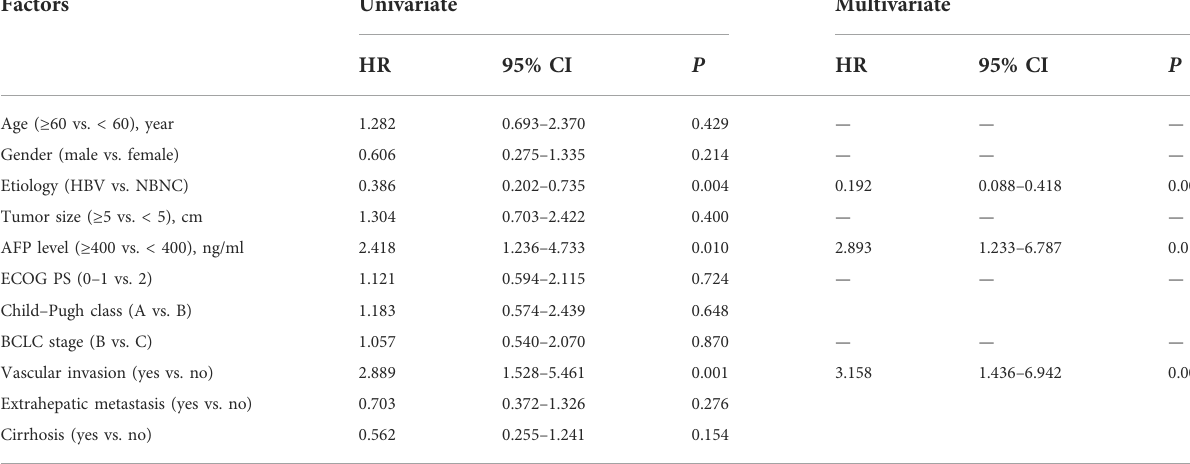
TABLE 3 Univariate and multivariate analyses of the prognostic factors for progression-free survival. Factors